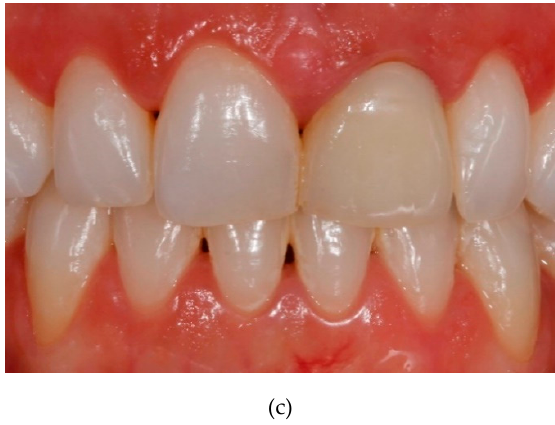
Figure 7. ( a ) Image of Group 1S patient before whitening treatment. ( b) Photograph of Group 1S patient after in-o ffi ce whitening. ( c ) Appearance of teeth of a Group 1S patient after home whitening. Appl. Sci. 2020 , 10 , x FOR PEER REVIEW Figure 7. (a) Image of Group 1S patient before whitening treatment. (b) Photograph of Group 1S patient after in-office whitening. (c) Appearance of teeth of a Group 1S patient after home whitening .